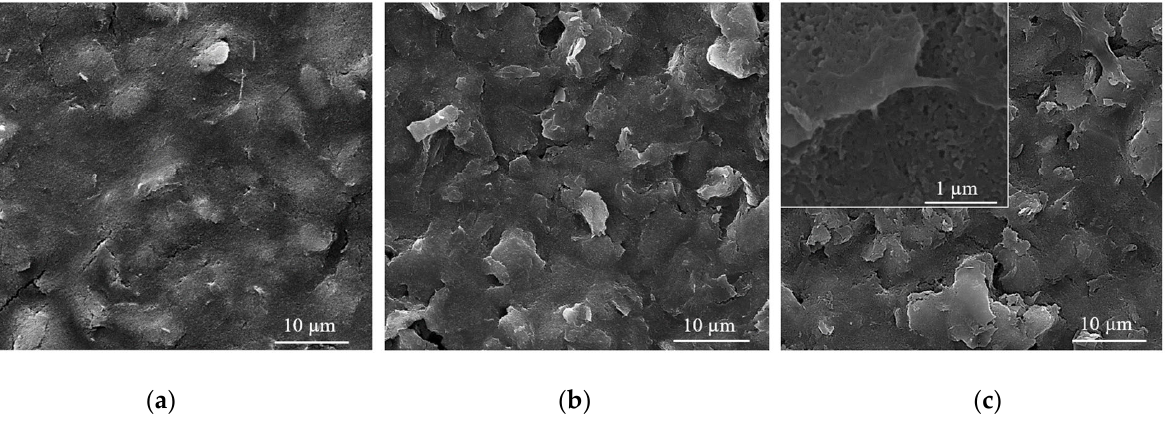
Figure 5. SEM images of ( a ) bare C ‐ SPE surface; ( b ) C ‐ SPE coated with a CNT ‐ Chit ‐ FePc film obtained from a (22% CNT + 1% Chit + 0.4% FePc) in H 2 O target; ( c ) the same C ‐ SPE coated with a CNT ‐ Chit ‐ FePc film after 200 cyclic voltammograms.